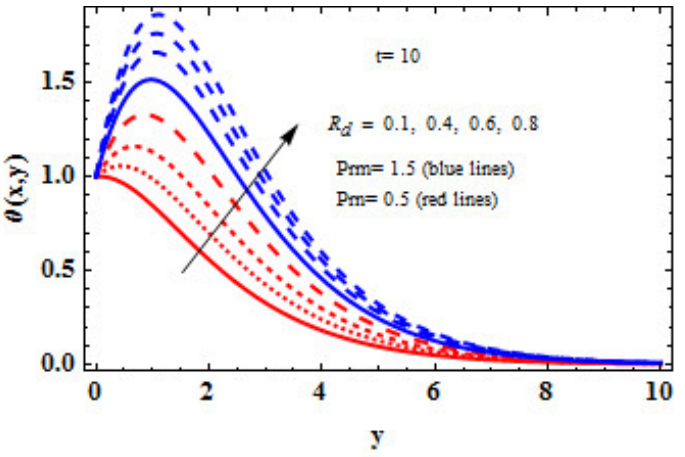
Figure 8. M effect on temperature with respect to Prm.